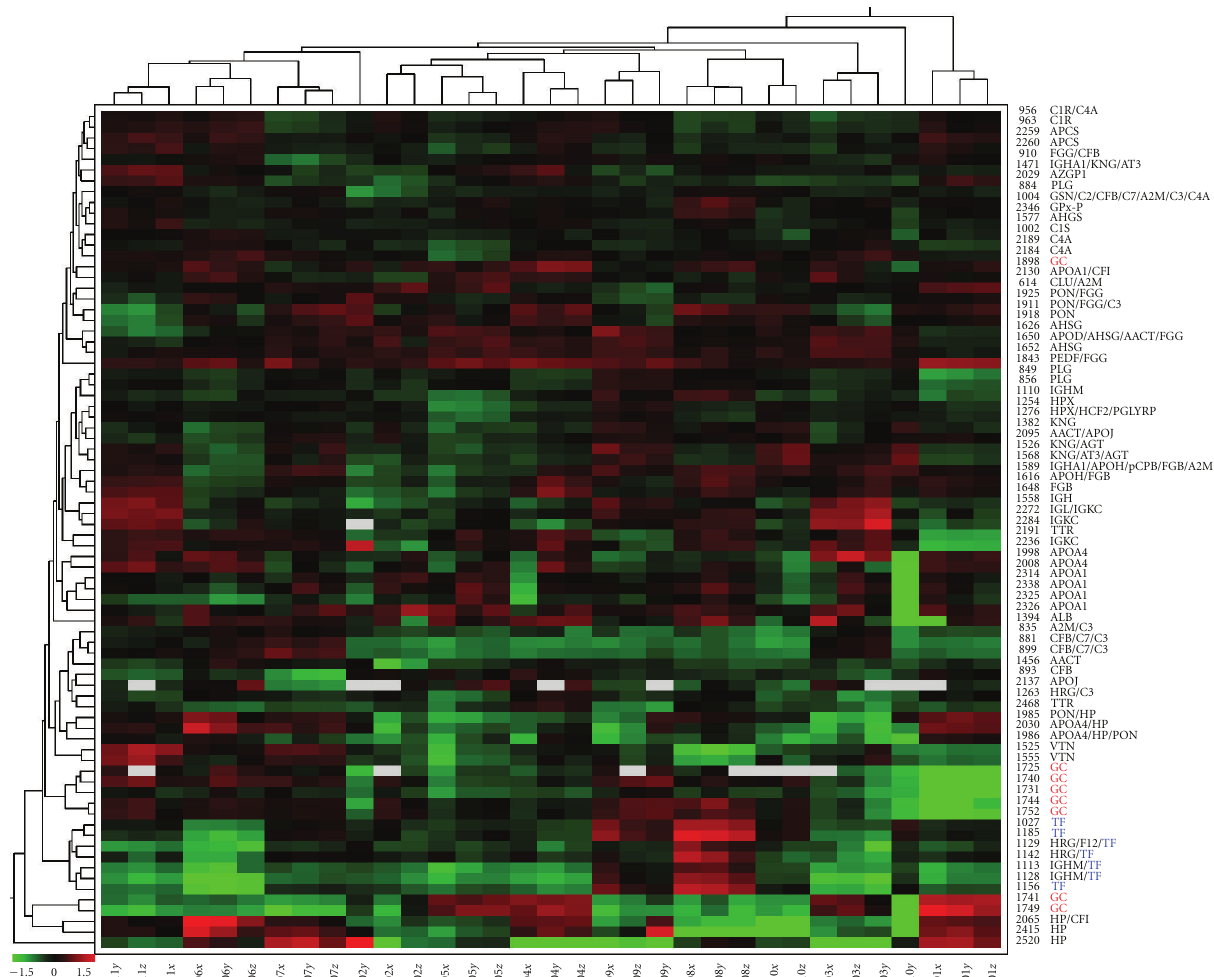
Figure 6: Hierarchical clustering of the 33 samples ( x -axis) based on the abundance of the 78-identified protein spots on the y -axis, using Euclidean distance metrics and average linkage methods. The samples are in SubjectNumberTime format, where SubjectNumber ranges from 01 to 11, and the Time values ( x , y , and z ) correspond to ( T 1 , T 2 , and T 3 ). The intensities range from − 1.5 (bright green) to 1.5 (bright red). The dendrogram on the top indicates the order of the sample grouping, with samples corresponding to the lower leaves being grouped together first. Similarly, the dendrogram on the left indicates the ordering of the protein spots. All transferrin (TF) and vitamin D-binding protein (GC) identifications are highlighted in blue and red,